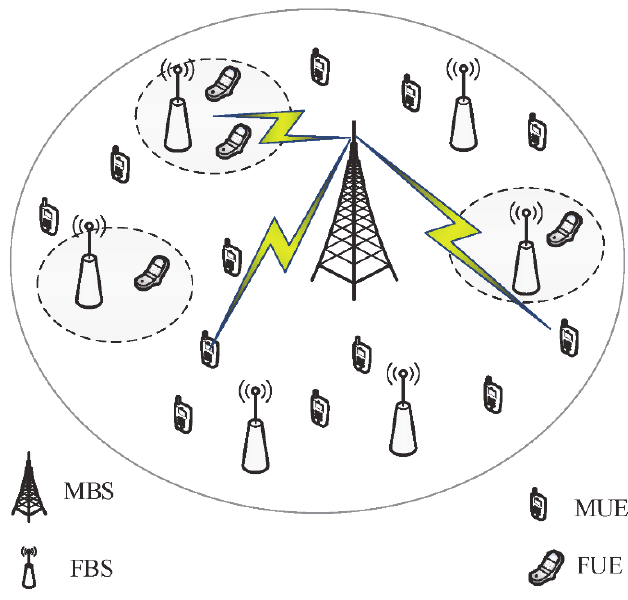
Fig. 1. Macro cell and small cells in a 5G heterogeneous network.